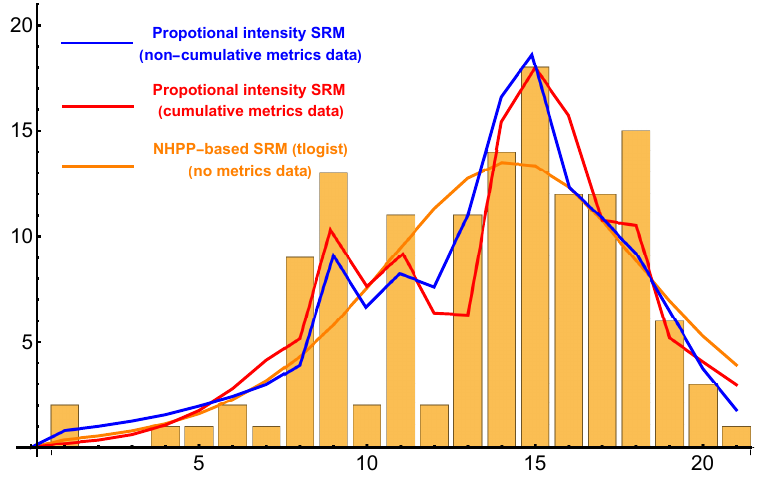
Figure 2. Behavior of estimated number of software faults in each time interval in GDS1. Table 4. Goodness-of-fit performance based on